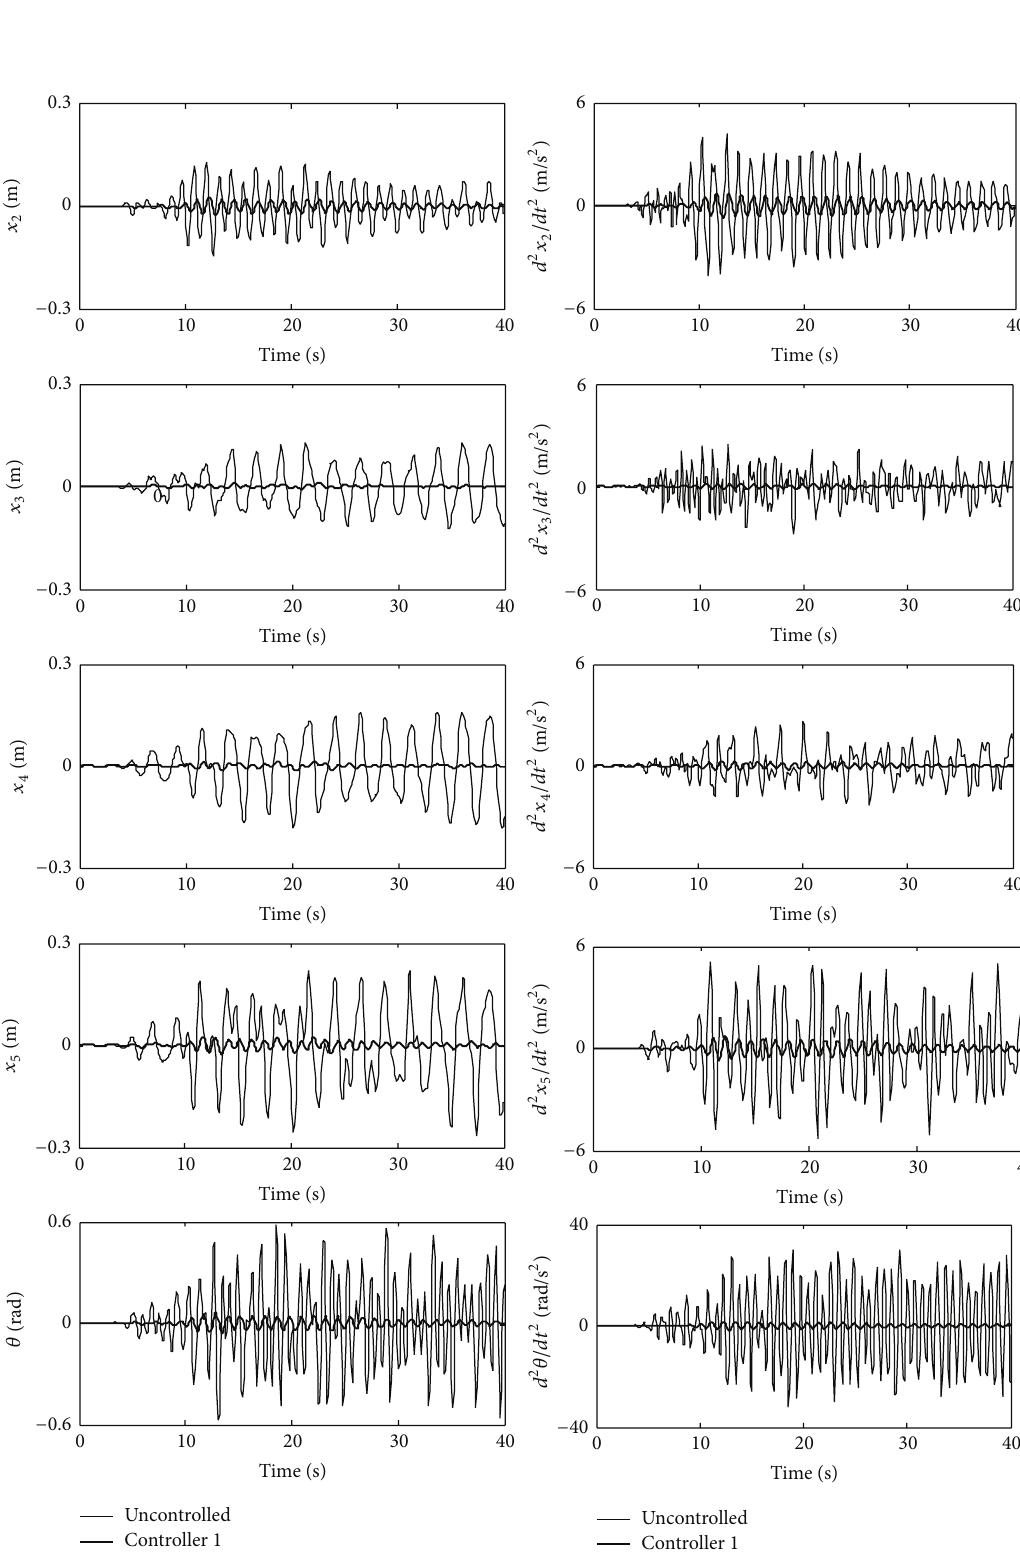
Figure 7: Time responses of the container crane against Northridge